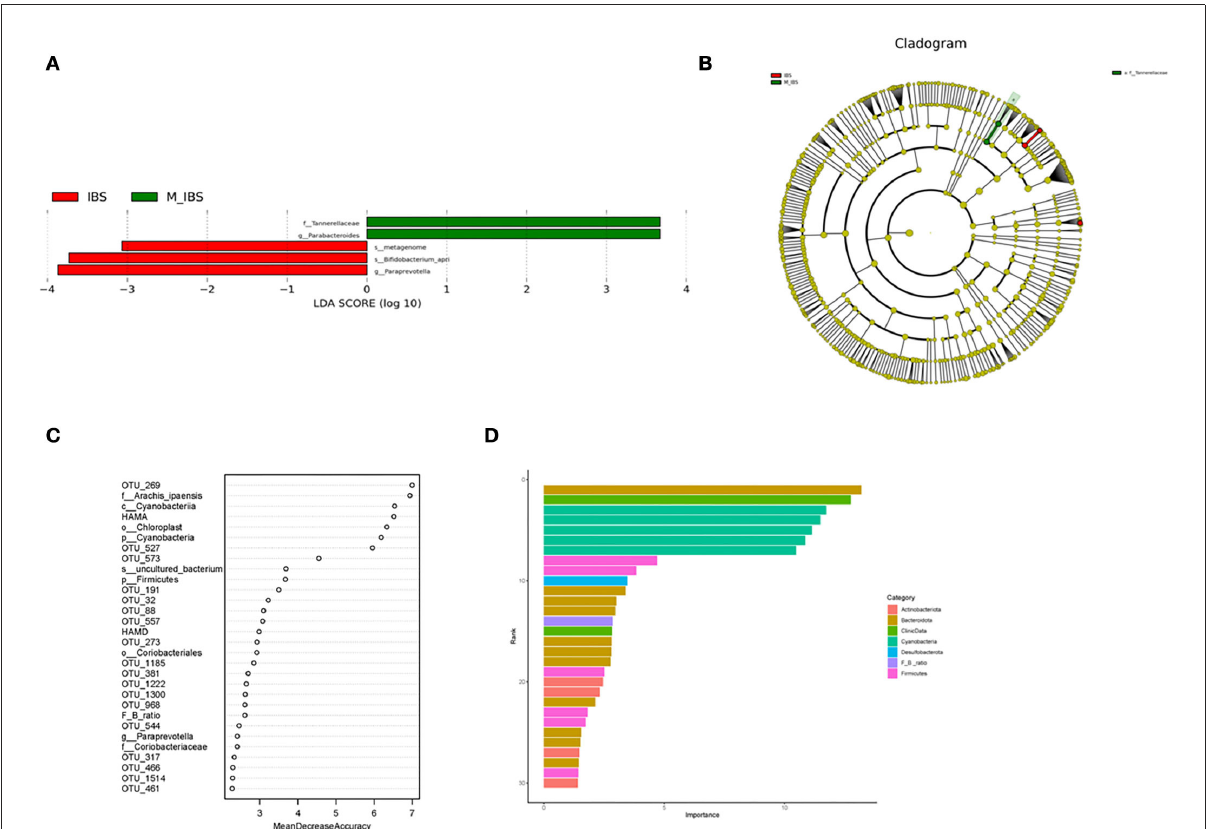
FIGURE4 Taxonomic differences in gut microbiota in the M_IBS and IBS groups. (A) Linear discriminant analysis (LDA) effect size (LEfSe) analysis revealed significant taxonomic differences in gut microbiota between the M_IBS group (positive score) and the IBS group (negative score). The LDA scores (log10) > 3 and P < 0.05 are listed. (B) Cladogram using the LEfSe method indicating the phylogenetic distribution of gut microbiota in the M_IBS and IBS groups. (C) The predictive model based on differentially abundant taxa and clinical data using an RF model. The relative importance of each index in the predictive model was determined using the mean decreasing accuracy and the Gini coefficient. (D) Variable importance of correlated phylum-level abundance taxa, F/B ratio, and clinical data. M_IBS, migraine with irritable bowel syndrome; IBS, irritable bowel syndrome; p, phylum; c, class; o, order; f, family; g, genus; s, species; LDA, linear discriminant analysis; LEfSe, linear discriminant analysis effect size; RF, random forest; F/B ratio, Firmicutes/Bacteroidetes